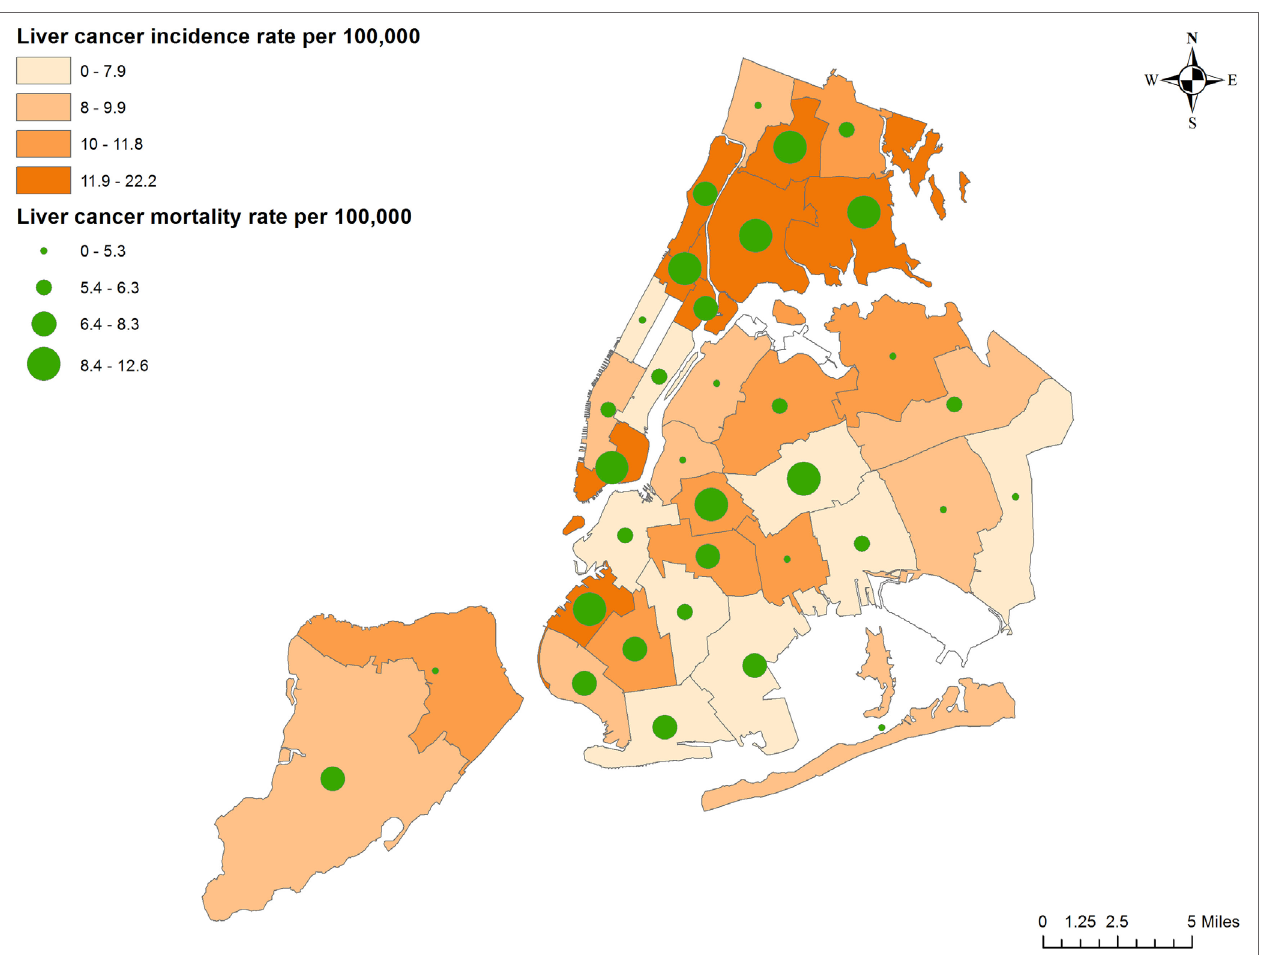
FigUre 1 | Liver cancer incidence and mortality rates according to